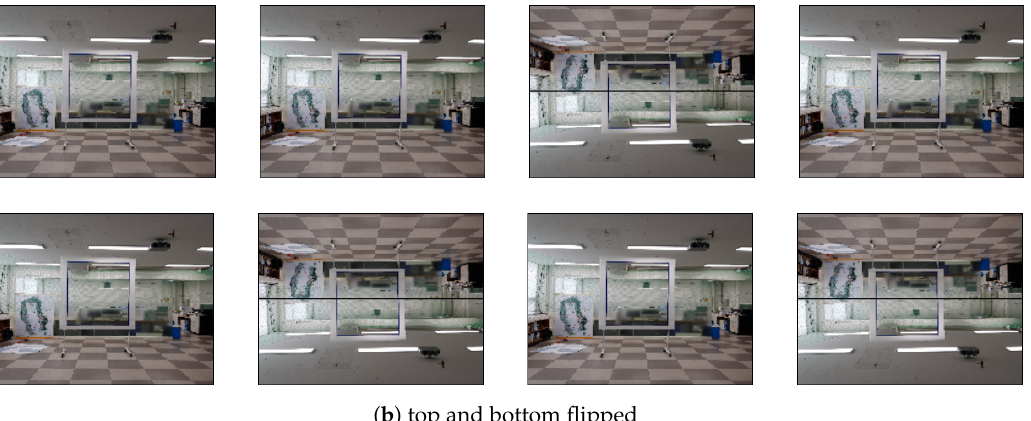
Figure 4. Left and right and top and bottom flipped images used for